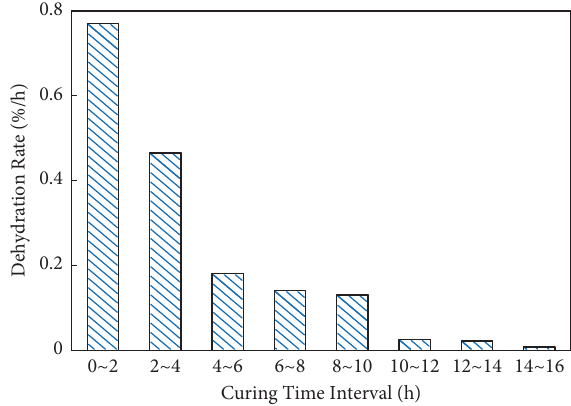
Figure 11: Change of dehydration rate with curing time.